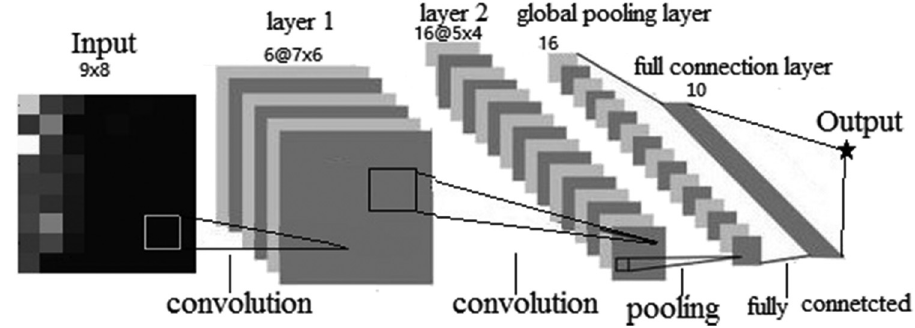
Figure 9: Structure diagram of CNN outlier detection